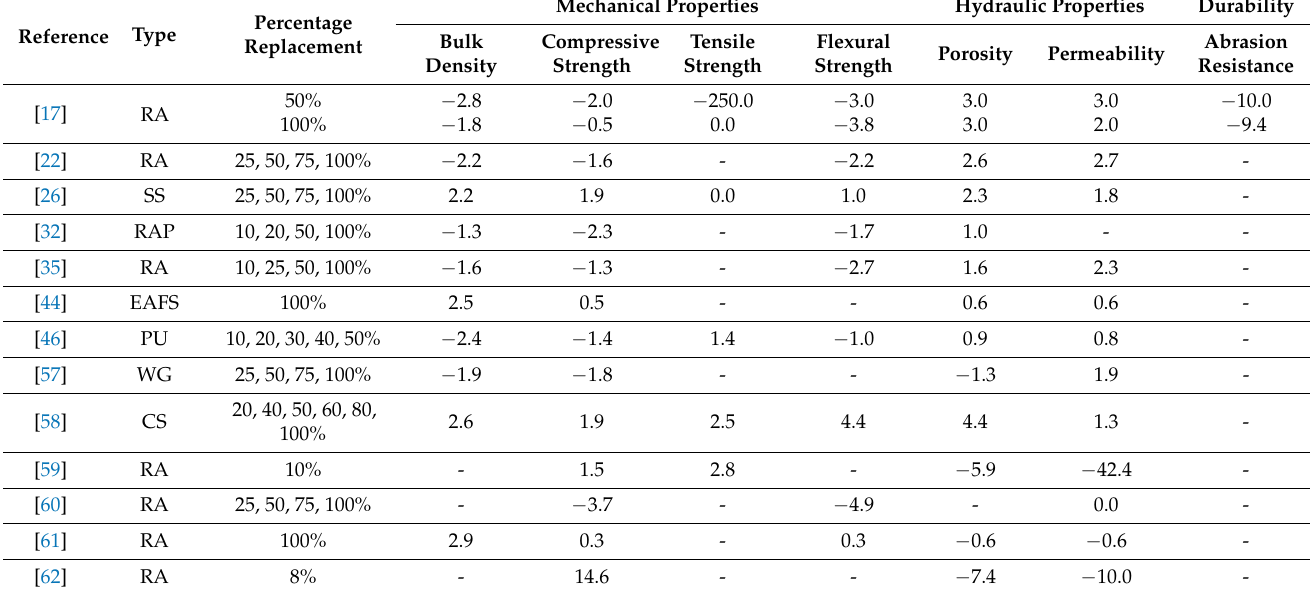
Table 2. Effect size for PC performance based on aggregate